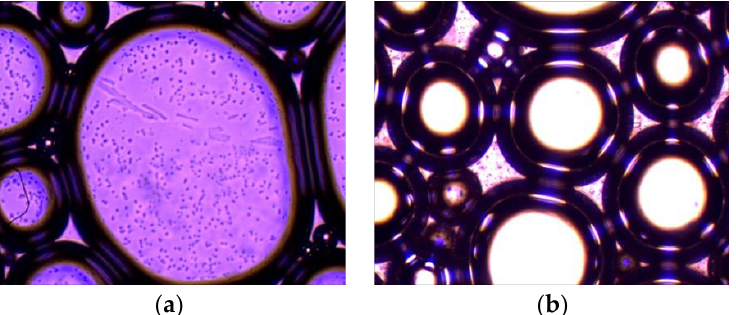
Figure 4. Microstructure of the foam. (Note: ( a ) shows without adding the foaming agent, and ( b ) shows adding the foaming agent).